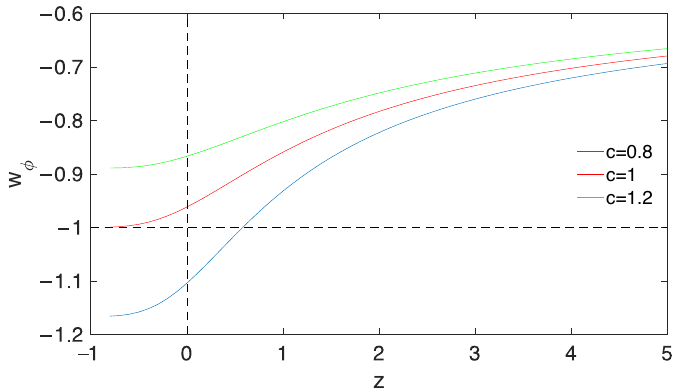
Figure 4. The evolution of the effective torsion EoS w φ versus redshift z